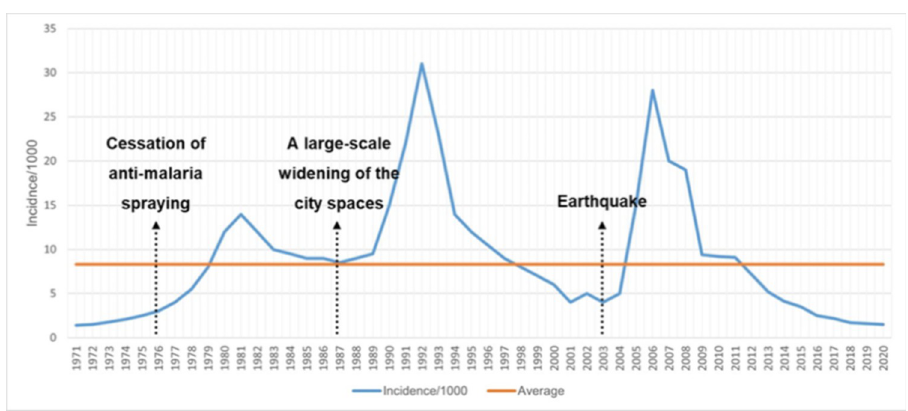
Fig 4. Repeated outbreak waves following the cessation of spraying against malaria, an extensive widening of the city spaces, and an earthquake occurred in Bam, southeastern Iran (1971–2020).